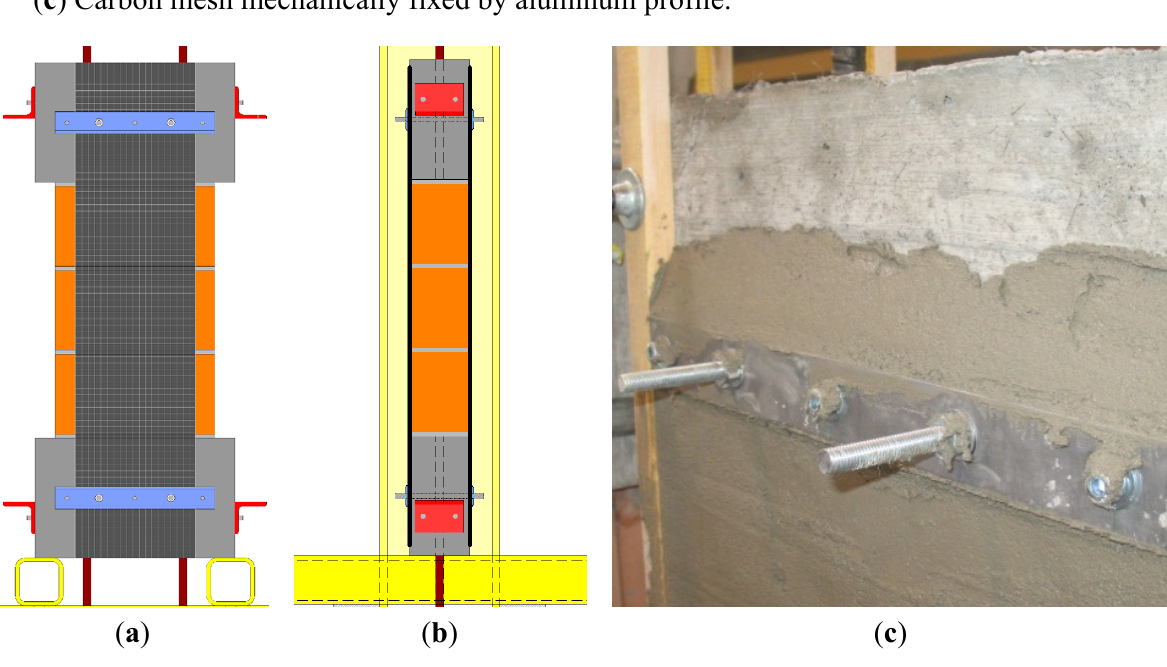
Figure 12. ( a , b ) Model of specimen in Series AT-F in view and sectional drawing;